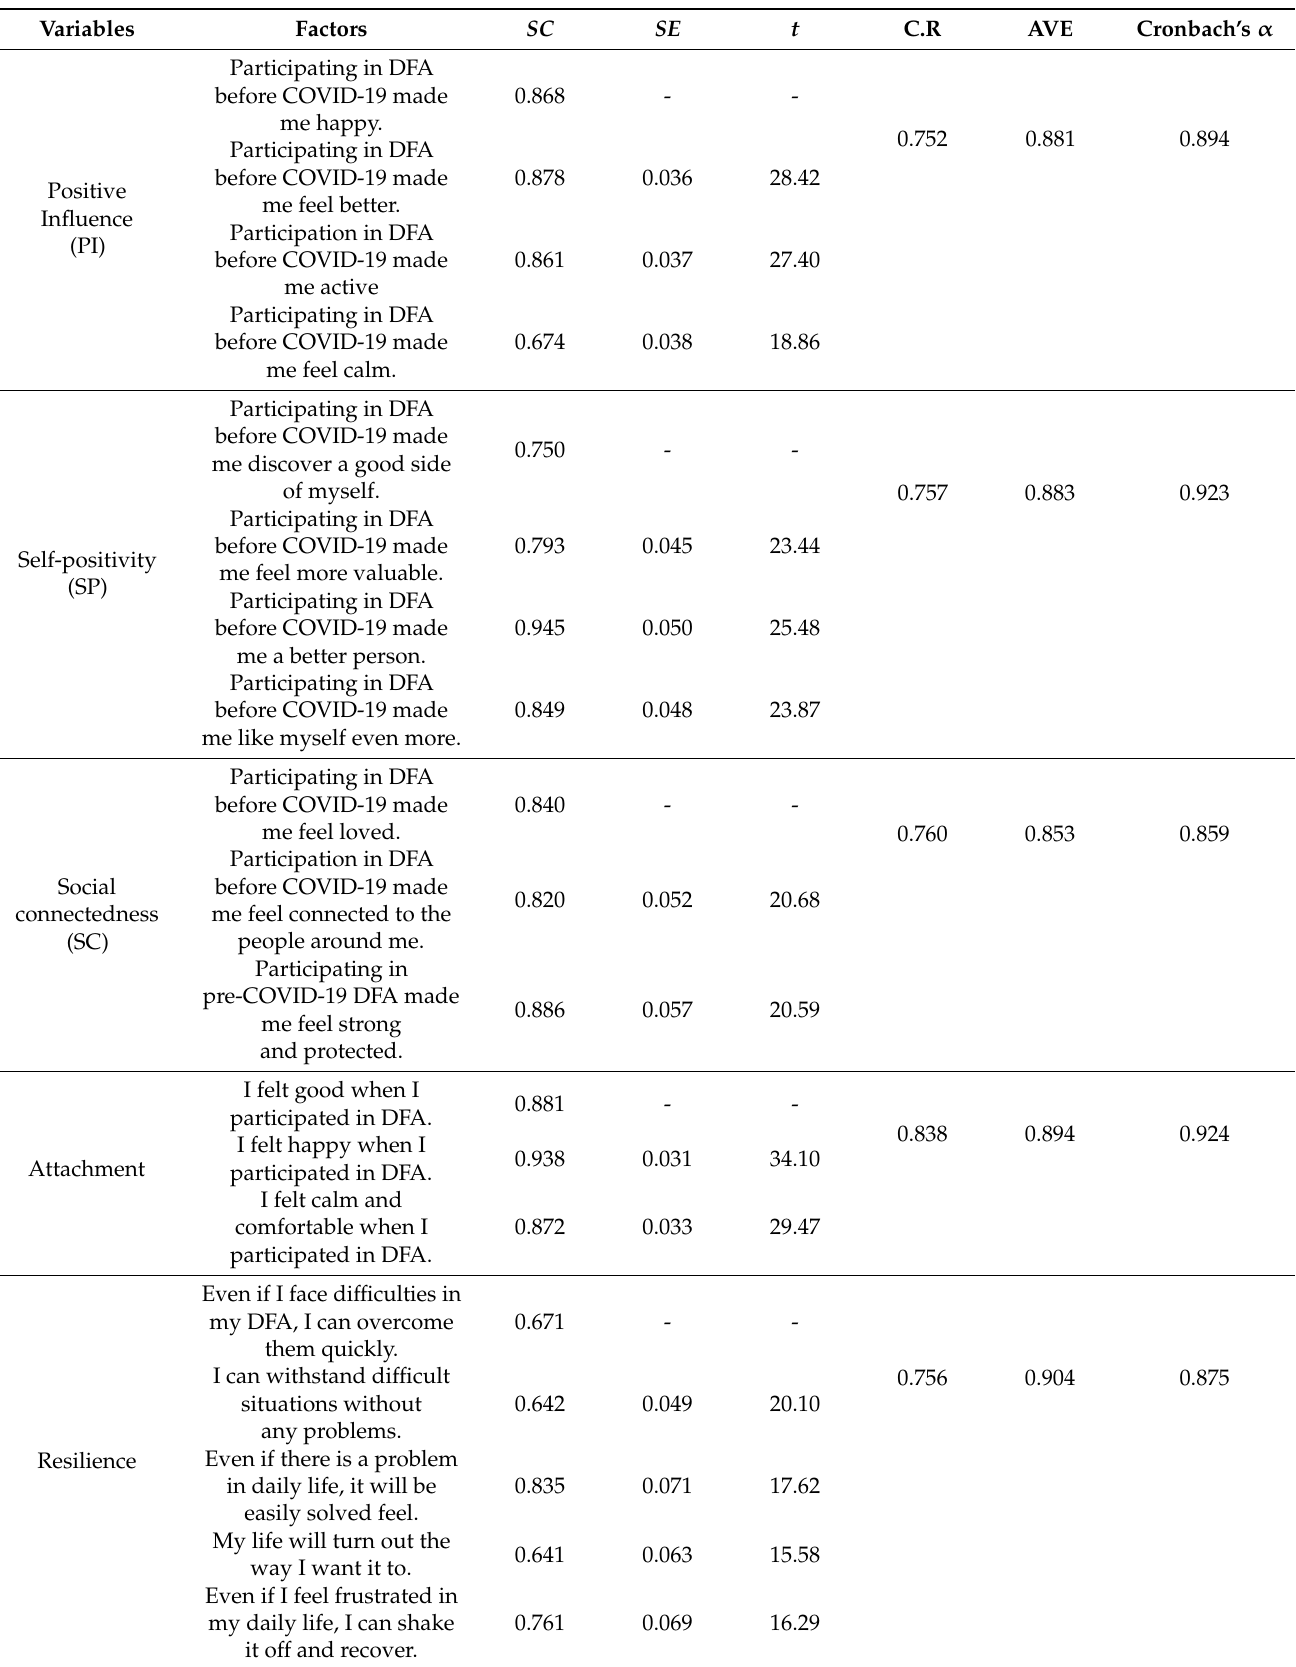
Table 2. Confirmatory factor